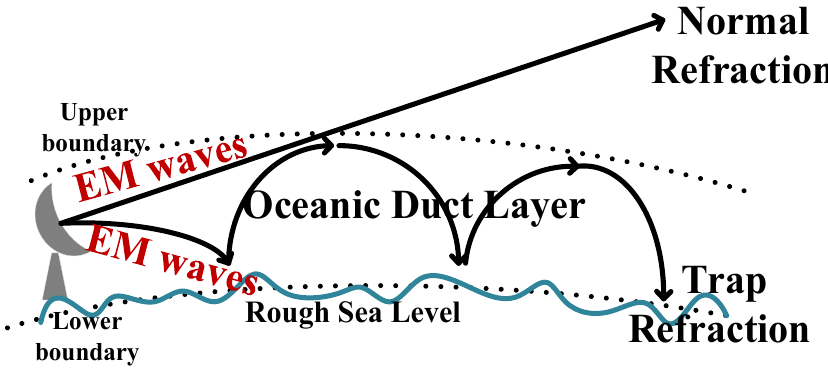
Figure 1. Propagation of electromagnetic waves in an oceanic duct layer.